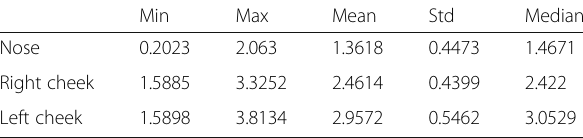
Table 1 Breakdown data of the vectors ’ magnitude in all three major areas of the face presented in Fig.